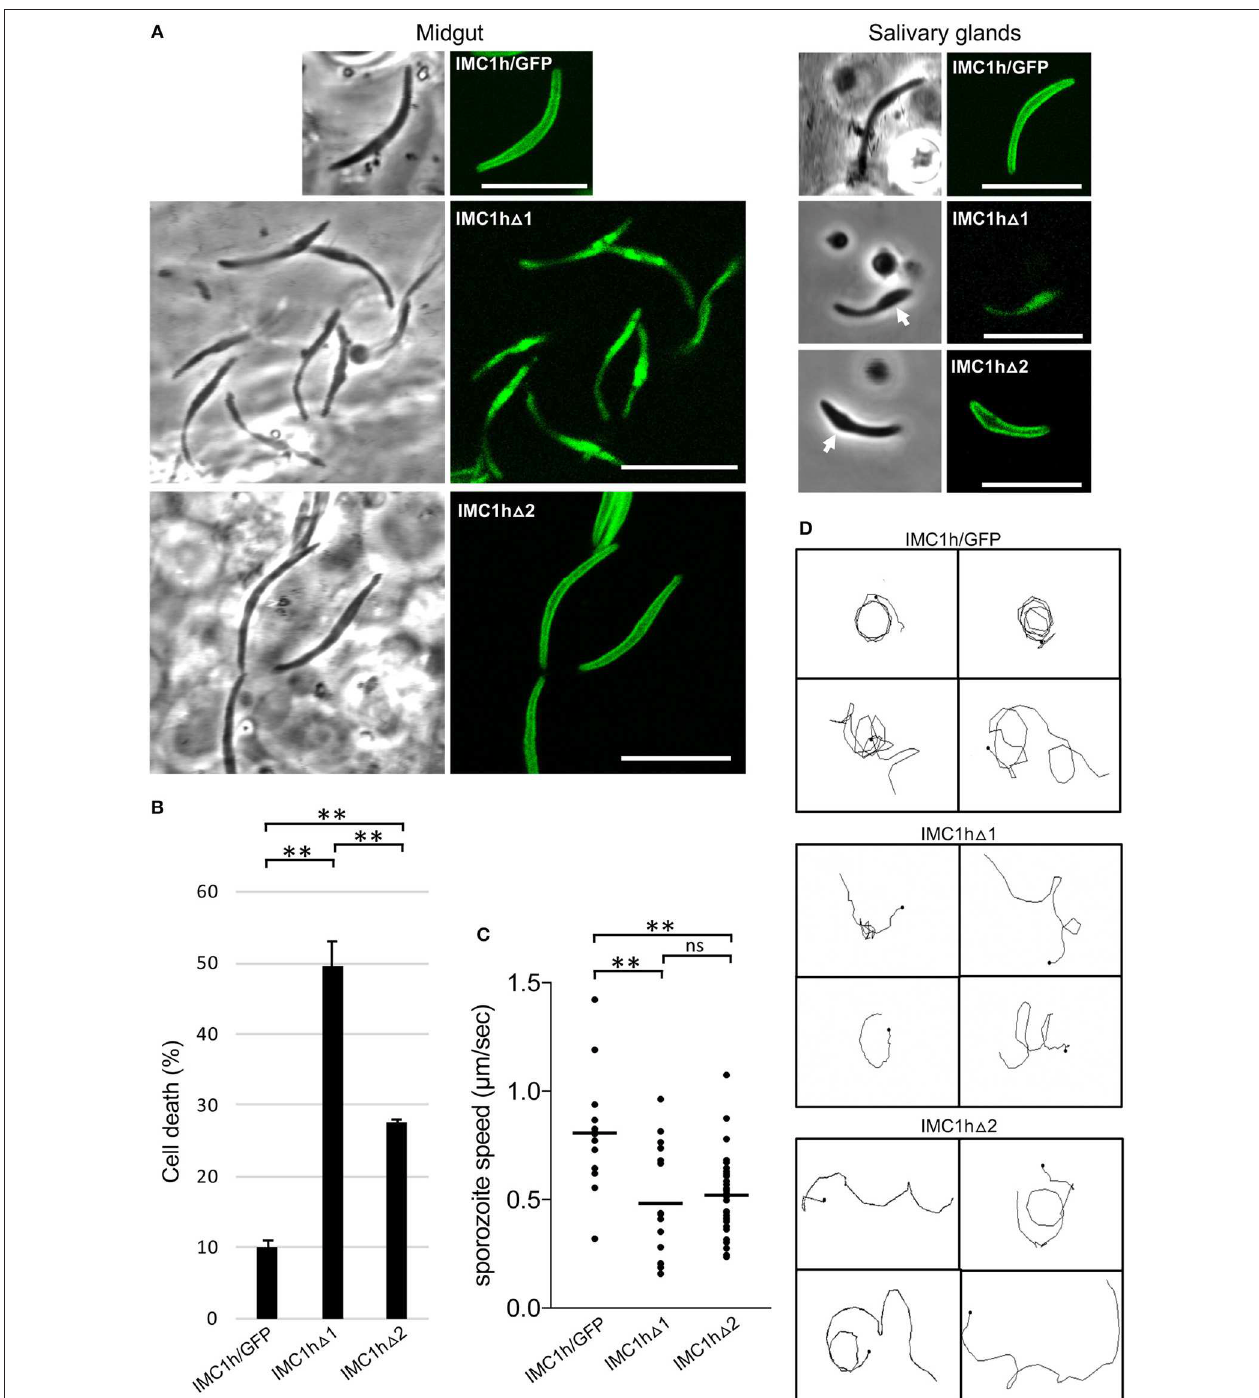
FIGURE 3 | Sporozoite-specific subcellular localization of IMC1h::GFP in IMC1h mutants, and their phenotypes. (A) Confocal GFP fluorescence and brightfield images of sporozoites of IMC1h mutant parasite lines. Note that IMC1h 1 2 sporozoites display normal cortical localization of the GFP fusion protein and have normal shape in midguts, but abnormal shape with bulging area (white arrow) in salivary glands. Scale bar = 10 µ m. (B) Percentage cell death after hypo-osmotic shock (0.33 × normal strength for 5min). Cell death inversely correlates to tensile strength. *statistically significant differences ( P < 0.05). Error bars indicate S.E.M. values from two experiments. (C) Sporozoite speed expressed in µ m/s. Images were captured every 10s over a 2min period. Plot is based on pooled data from two independent experiments and > 60 sporozoites analyzed. Horizontal lines mark mean values. **statistically significant differences ( P < 0.005). ns, not significant. (D) Representative images of reconstructed 3D movement patterns from time-lapse movies of IMC1h mutants in Matrigel. The trajectories reveal the more meandering movement of IMC1h 1 1 and IMC1h 1 2 sporozoites compared to the more circular movement of IMC1h/GFP sporozoites.